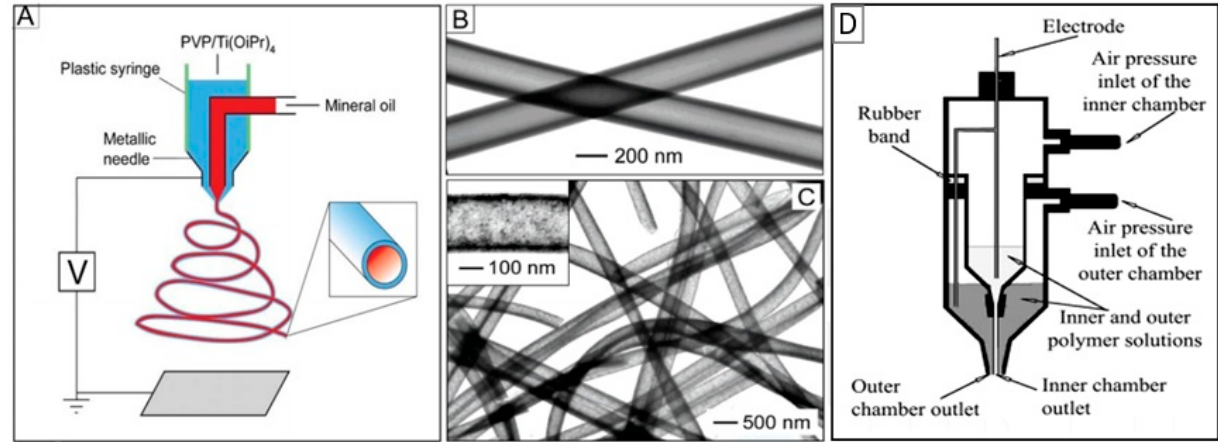
Figure 4. ( A ) Schematic illustration of the setup for coaxial electrospinning; ( B , C ) SEM images of TiO 2 hollow nanofibers; ( D ) experimental setup used for coaxial electrospinning of core/sheath nanofibers. In this installation with a non-conductive spinneret and needle, unlike the traditional approach, a high voltage is applied directly to the solution using a special electrode. ( A – C ) Reprinted with permission from [55]. Copyright 2004: Wiley; ( D ) Reprinted from [56]. Copyright 2003 Wiley.